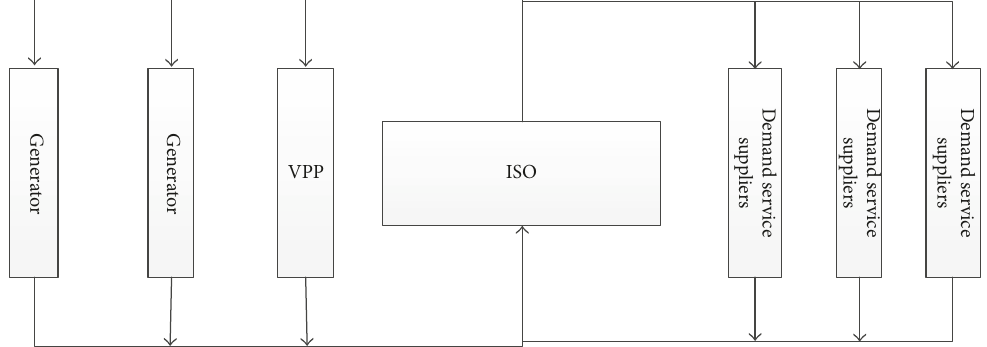
Figure 1: Bidding model in electricity